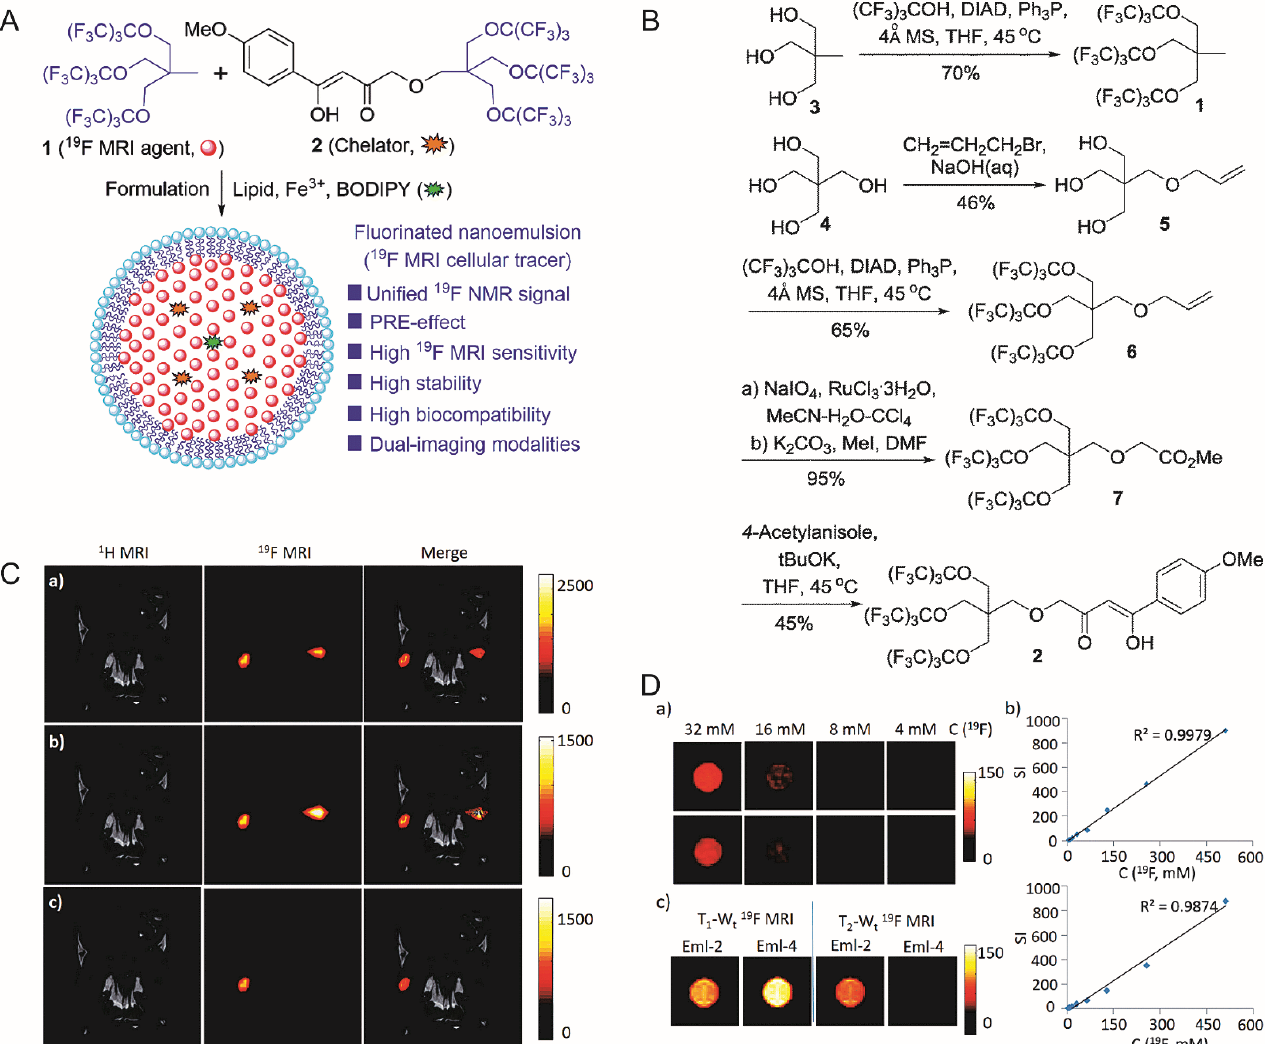
Figure 4. ( A ): Design of the nanoemulsion as 19 F-MRI cellular tracer. ( B ): Synthesis of 19 F-MRI agent 1 and chelator 2. ( C ): In vivo, 19 F-MRI tracking of Eml-2- and Eml-4-labeled RAW264.7 cells in mice. (Upper) 19 F density MRI; (Middle) T 1 -weighted 19 F-MRI; (Lower) T 2 -weighted 19 F-MRI; (Left) Eml-2-labeled cells were injected; (Right) Eml-4 labeled cells were injected for comparison. ( D ): (Upper left, middle left) 19 F density MRI of Eml-2 and Eml-4, respectively; (Right) is SI versus C( 19 F) of Eml-2 and Eml-4, respectively; (Lower left) 19 F T 1 /T 2 -W t MRI of Eml-2 and Eml-4 at 9.4T. [76] . Reproduced with permission from Royal Society of Chemistry 2018.